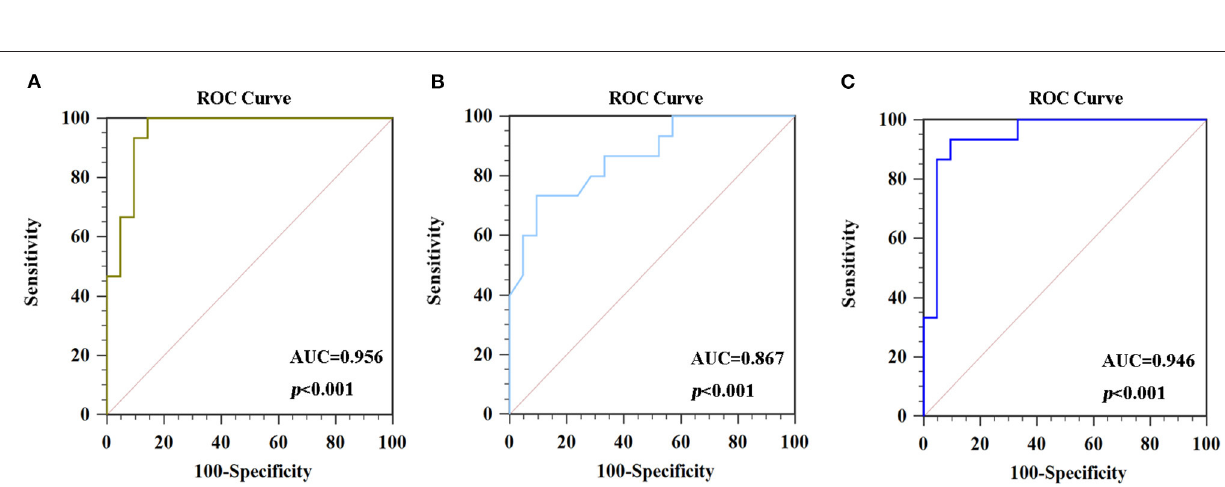
FIGURE 4 | ROC curve analysis of average signals in altered brain regions. (A) The AUC was 0.956 ( p < 0.001; 95% CI 0.829–0.996) for ReHo values in the CAL.L. (B) The AUC was 0.867 ( p < 0.001; 95% CI 0.712–0.957) for ReHo values in the SFG.L. (C) The AUC was 0.946 ( p < 0.001; 95% CI 0.816–0.994) for fALFF values in the IPL.L. ROC, receiver operating characteristic curves; AUC, area under the curve; ReHo, regional homogeneity; fALFF, fractional amplitude of low-frequency fluctuation.